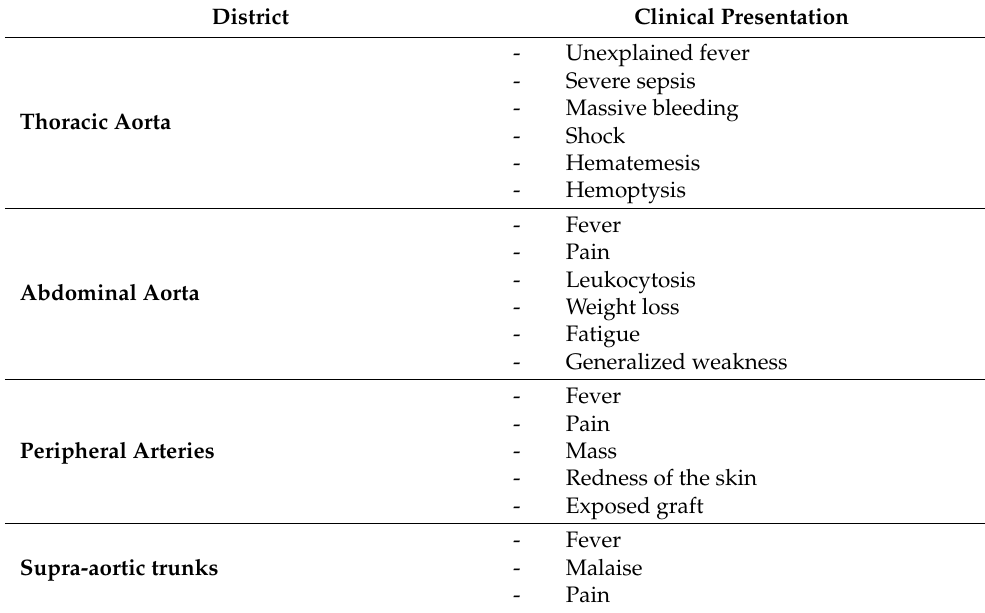
Table 2. Main clinical presentations of VGEI.